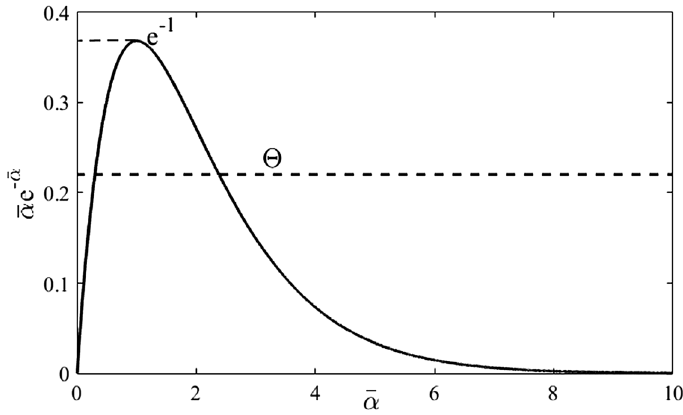
Figure 6. Intersections of a constant function (cid:31) and α e − α (Lemma